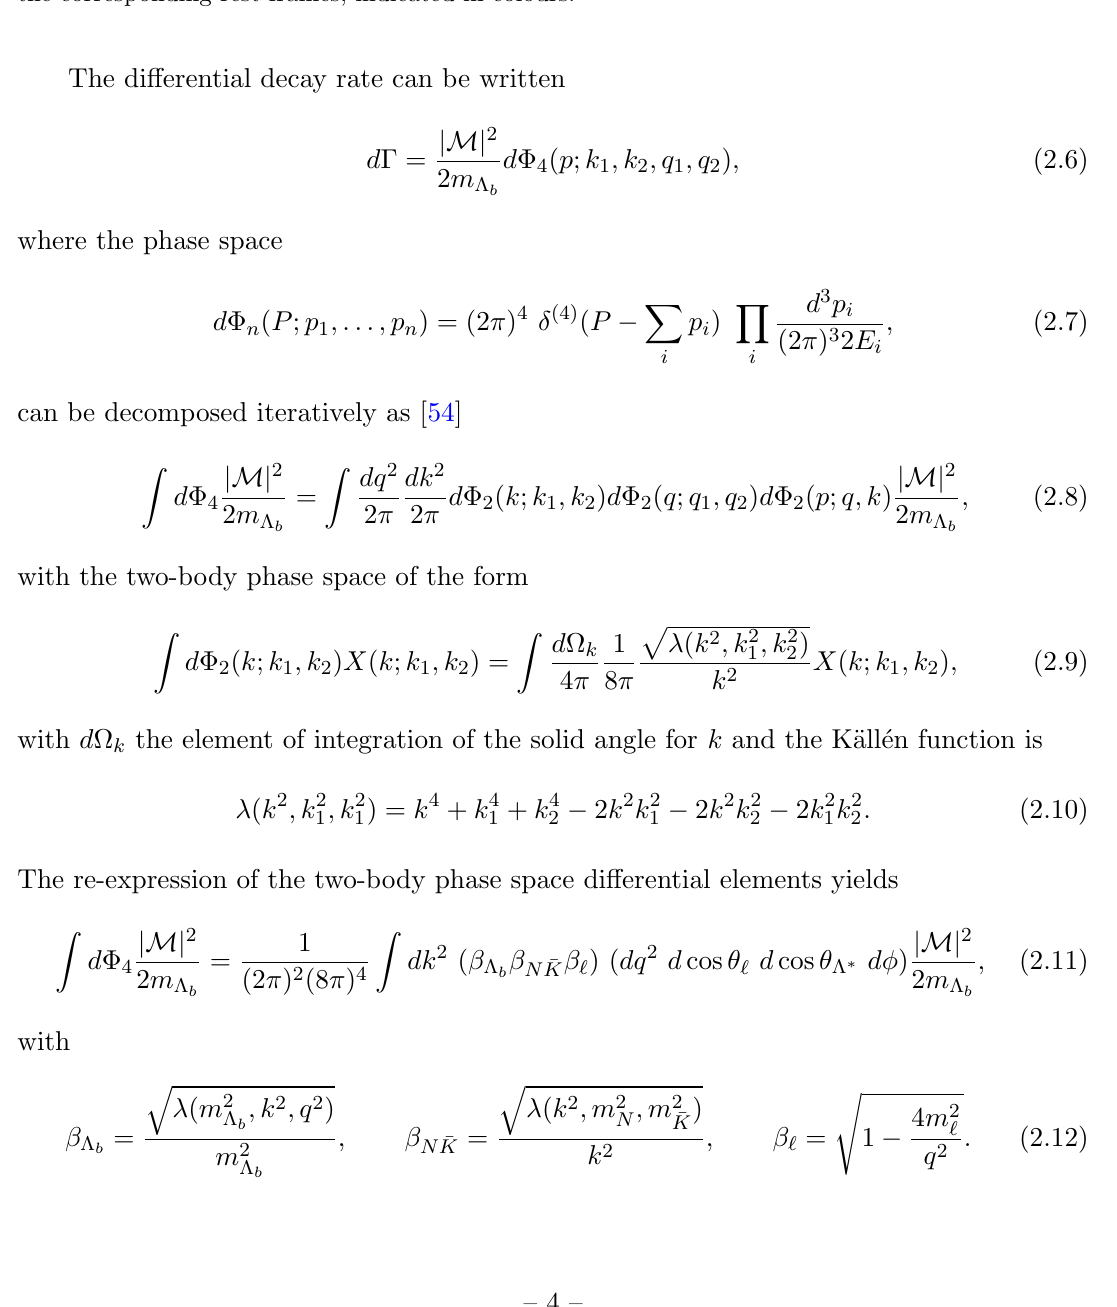
Figure 1 . Kinematics of the four-body (cid:3) b ! (cid:3) (cid:3) ( ! N (cid:22) K ) ‘ + ‘ (cid:0) decay. The angles are de(cid:12)ned in the corresponding rest frames, indicated in